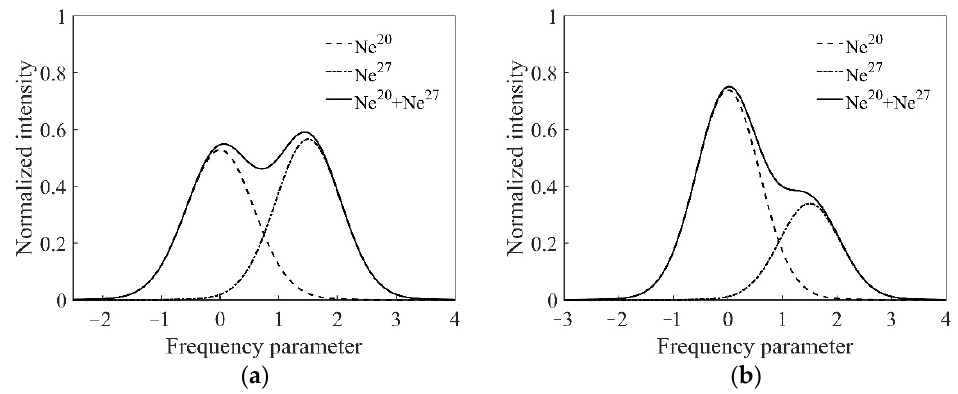
Figure 3. The normalized results of the intensity tuning curve in the ring laser gyro. ( a ) Ne 20 :Ne 22 = 1:1, inflation pressure 400 Pa; ( b ) Ne 20 :Ne 22 = 7:3, inflation pressure 400 Pa.